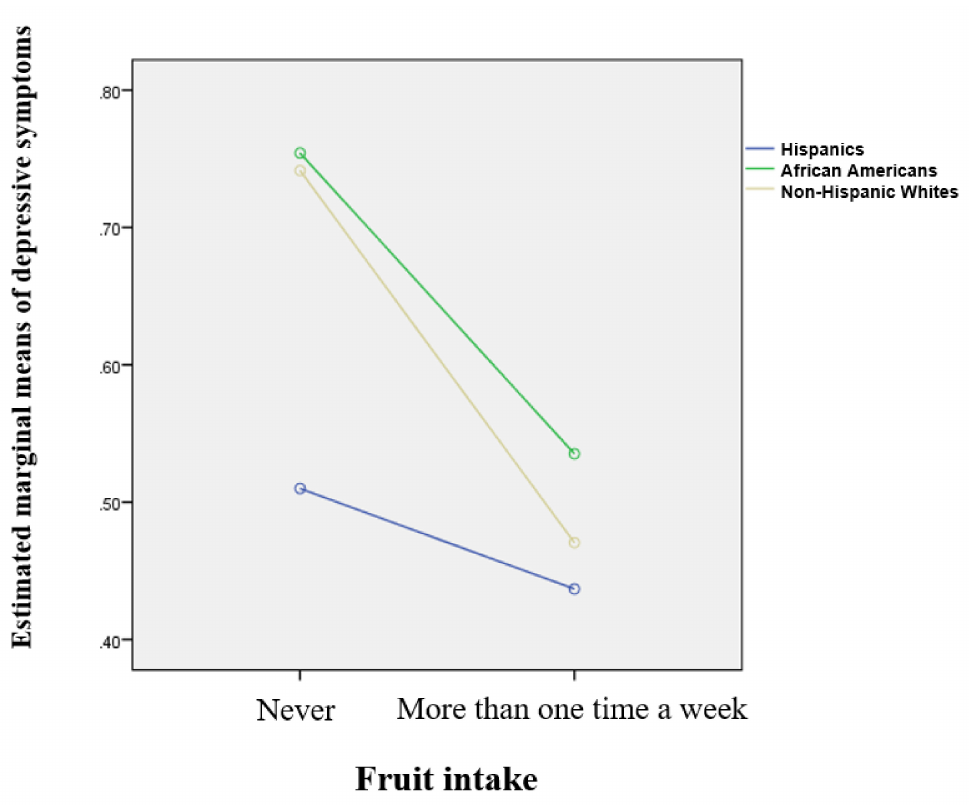
Figure 1. Roles of fruit intake and race / ethnicity on depressive